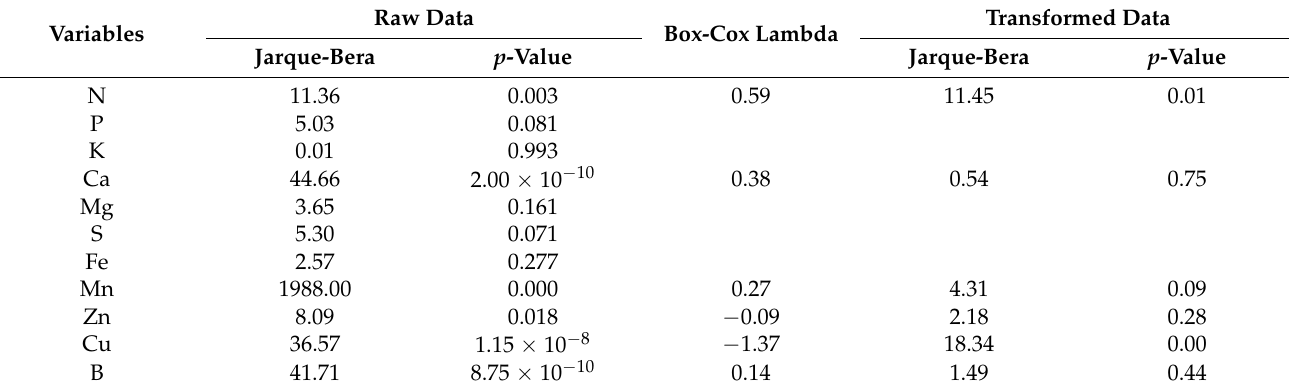
Table 2. Jarque–Bera test of normality for raw and transformed